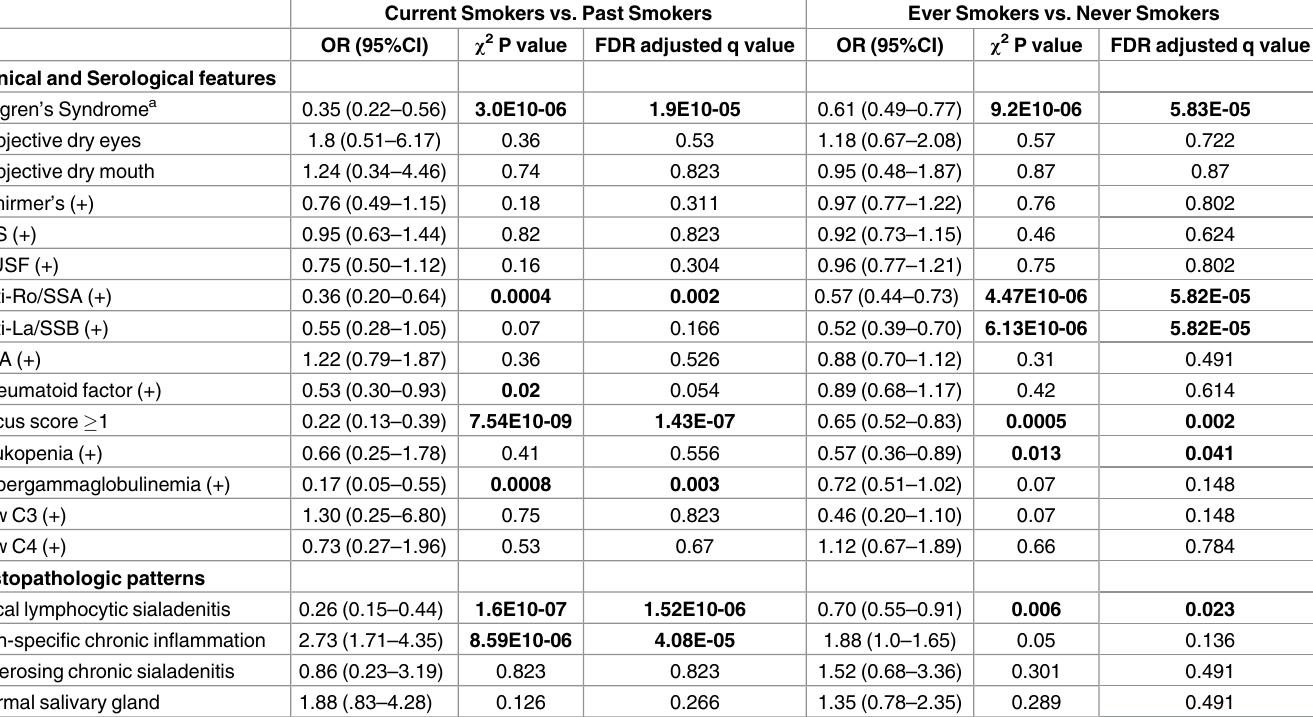
Table 3. Risk of classification as Sjo¨gren’s syndrome and presenceof associated disease criteria and histopathologic patterns based on smoking